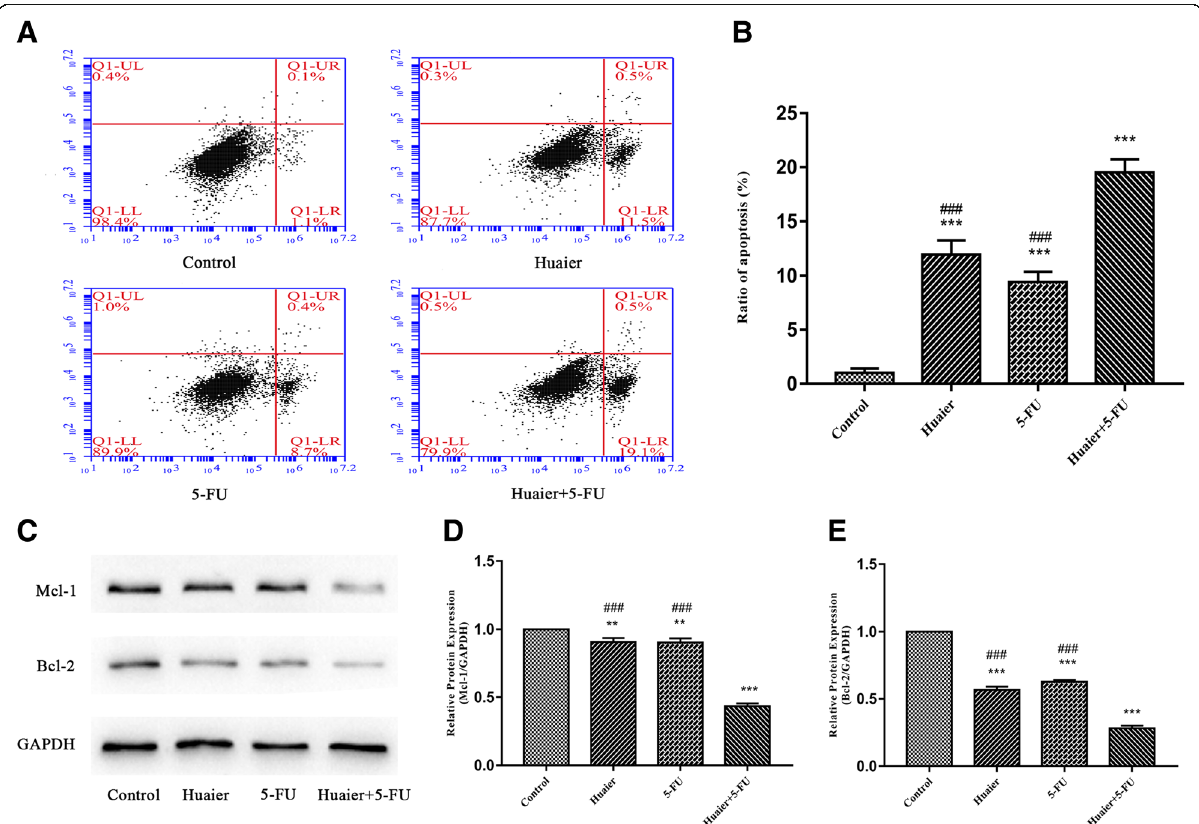
Fig. 2 Apoptosis induction effect of Huaier and 5-FU in single agent or combination on Huh28 cells. a Flow cytometry histograms of Huh28 cells after 48 h treatment with Huaier (6 mg/ml) and 5-FU (30 μ g/ml) alone or in combination, the samples were detected using AV/PI double-staining method. b The percentage of apoptotic cells was calculated, and results are shown in bar graph. c , d and e The expression levels of anti- apoptotic protein Mcl-1 and Bcl-2 in Huh28 cells after 48 h of different treatments were detected by Western blot, and the relative optical densities of proteins were analyzed by Image J. All results are expressed as mean ± SD of three independent experiments. * P < 0.05, ** P < 0.01, *** P < 0.001, compared with control group, while # P < 0.05, ## P < 0.01, ### P < 0.001, compared with combination